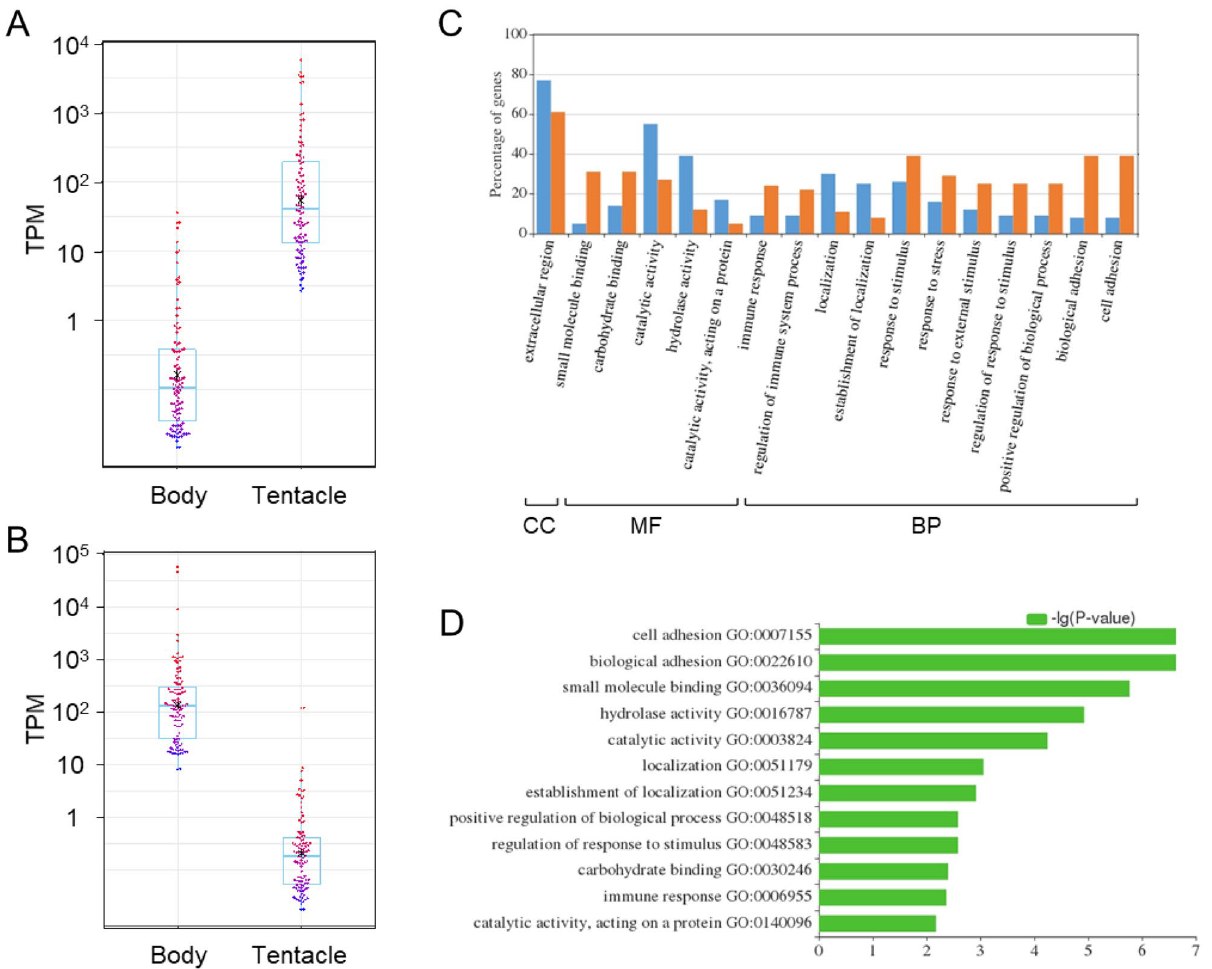
in each part are colored in the same gradation color according to the TPM value (red to blue form higher to lower value). ( B ) Box plot graph for the distribution of TPM value for top 100 genes highly expressing in the rest of body. Each gene is colored as in ( A ). ( C ) WEGO analysis of top 100 genes highly expressing in the tentacle (orange bar) and the rest of the body (blue bar). ( D ) P-values from Chi-square tests obtained by WEGO analysis. CC cellular component, MF molecular function, BP biological